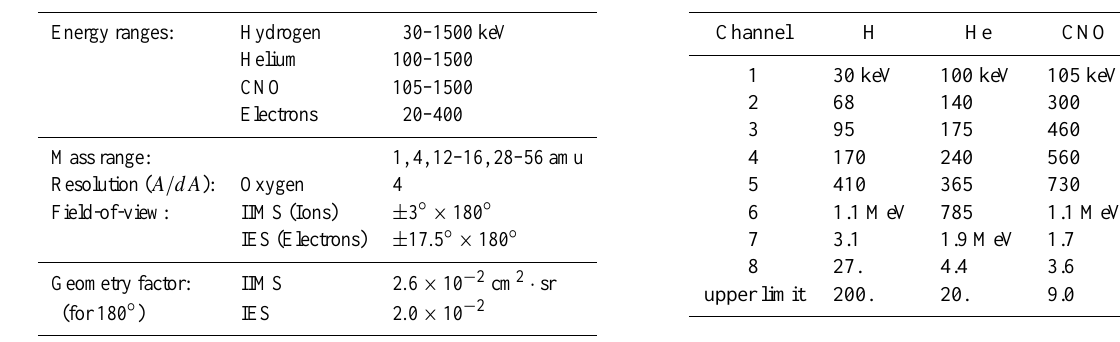
Table 1. Specifications for the RAPID spectrometer Table 2. RAPID Energy Channel definitions (approximate